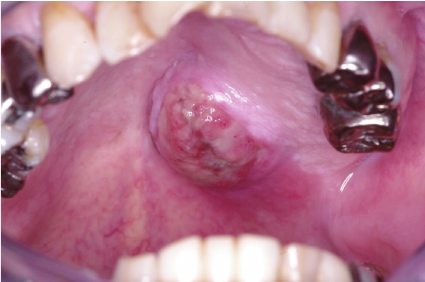
Figure 7: After re-biopsy, the lesion size rapidly increased and a malignant tumor was strongly